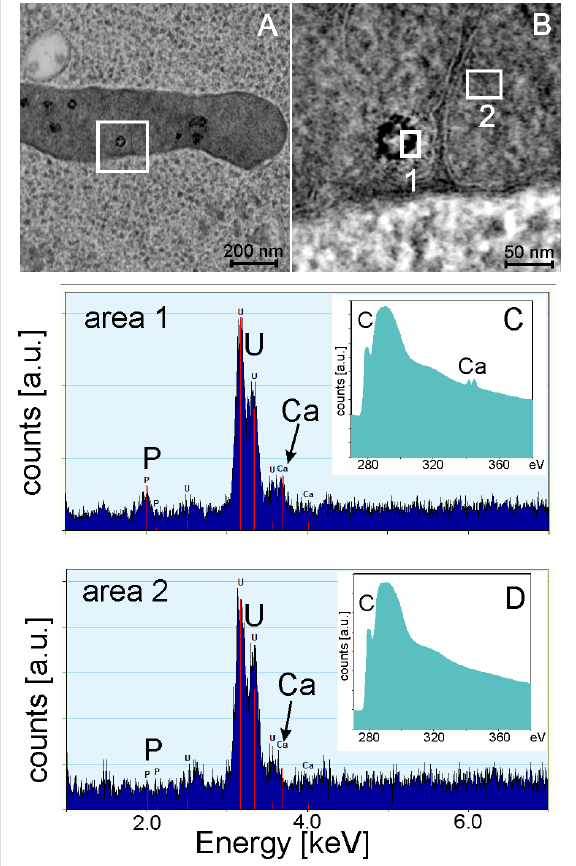
Figure 9: STEM high angular annular dark field (HAADF) micrograph of a mitochondrion containing darkly stained agglomerates (A) and magnification of the indicated area (B). Image contrast has been inverted to adapt the micrograph to the appearance of